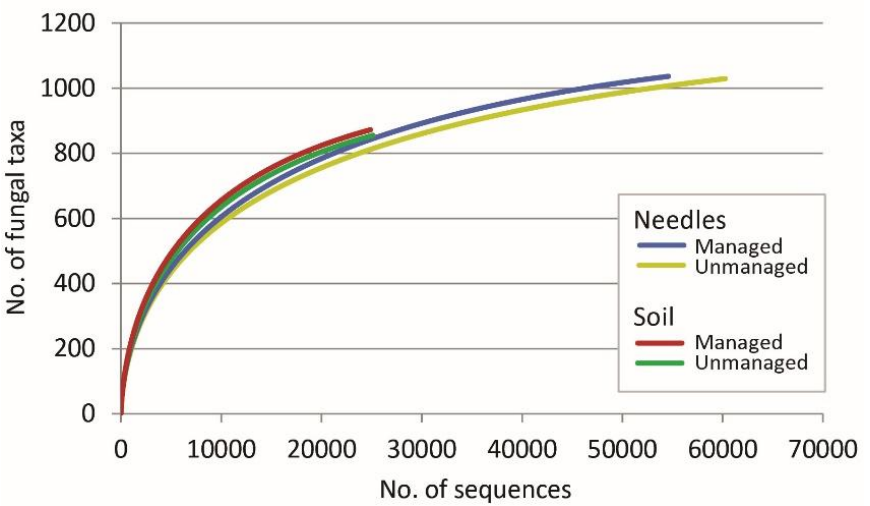
Figure 2. Rarefaction curves showing the relationship between the cumulative number of fungal taxa and the number of ITS2 rRNA sequences from living needles and soil from managed and unmanaged Pinus sylvestris forest